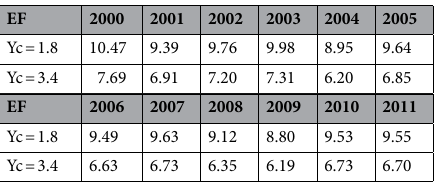
Table 1. Impact of carbon sequestration rate on EF from 2000 to 2011 (unit: gha).